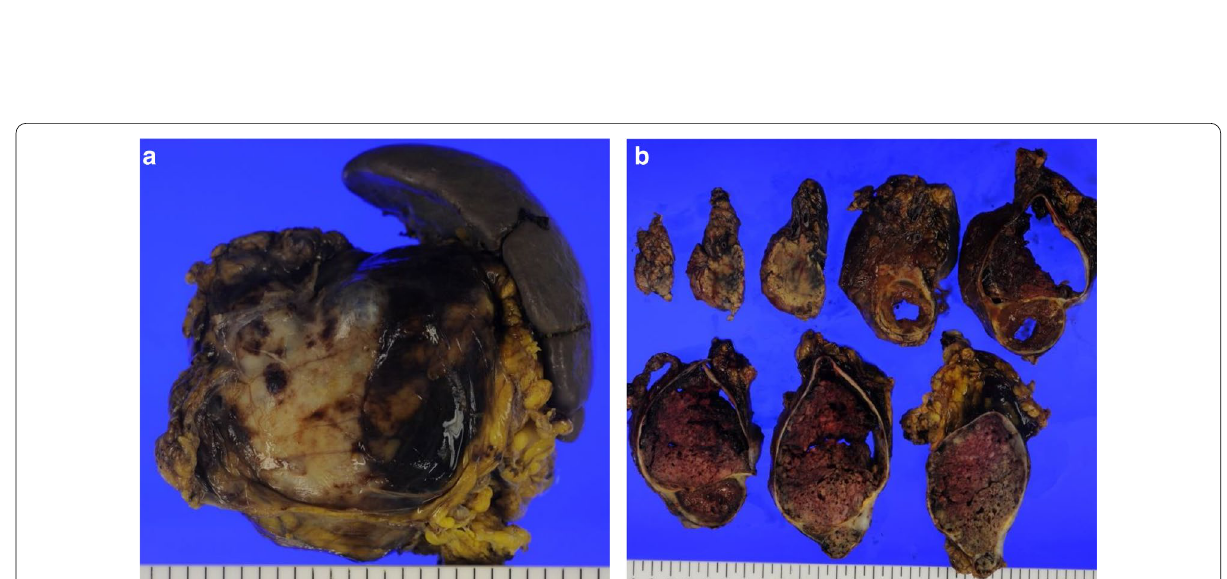
Fig. 3 Magnetic resonance imaging. The tumor had bleeding (arrow) shown by high intensity on T1-weighted images ( a ), and a low intensity on T2-weighted images ( b )